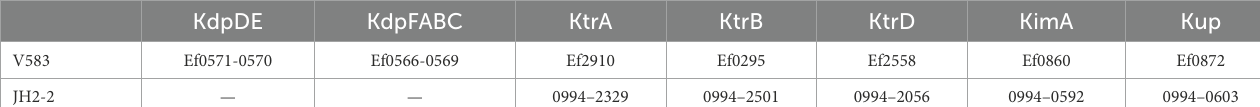
TABLE 1 Potassium transport systems present in Enterococcus faecalis strains.